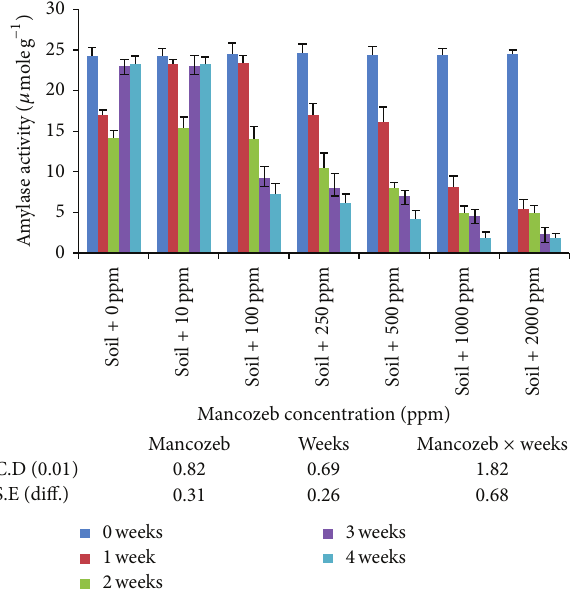
Figure 8: Effect of mancozeb on amylase in soil.